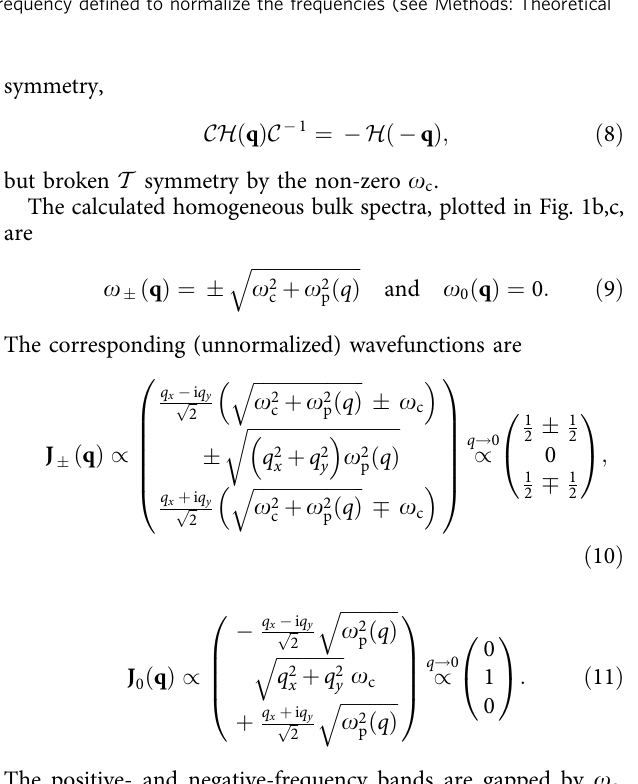
Figure 1 | Model system and analytically calculated homogeneous bulk spectra. ( a ) Schematics of the structure. (The presence of metal plates and dielectrics permits a general theoretical treatment but is not essential to the topological behaviours of 2D MP). ( b ) No magnetic field is present. The two circles connected by a dashed line represent the particle–hole symmetry of the dispersion curves. ( c ) A uniform magnetic field is applied along the positive z direction. Different branches carry different Chern numbers. The negative-frequency branch reflects the redundant degrees of freedom of the real-valued classical field and so is shaded. Here o c ¼ o (cid:4) , where o (cid:4) is a characteristic frequency defined to normalize the frequencies (see Methods: